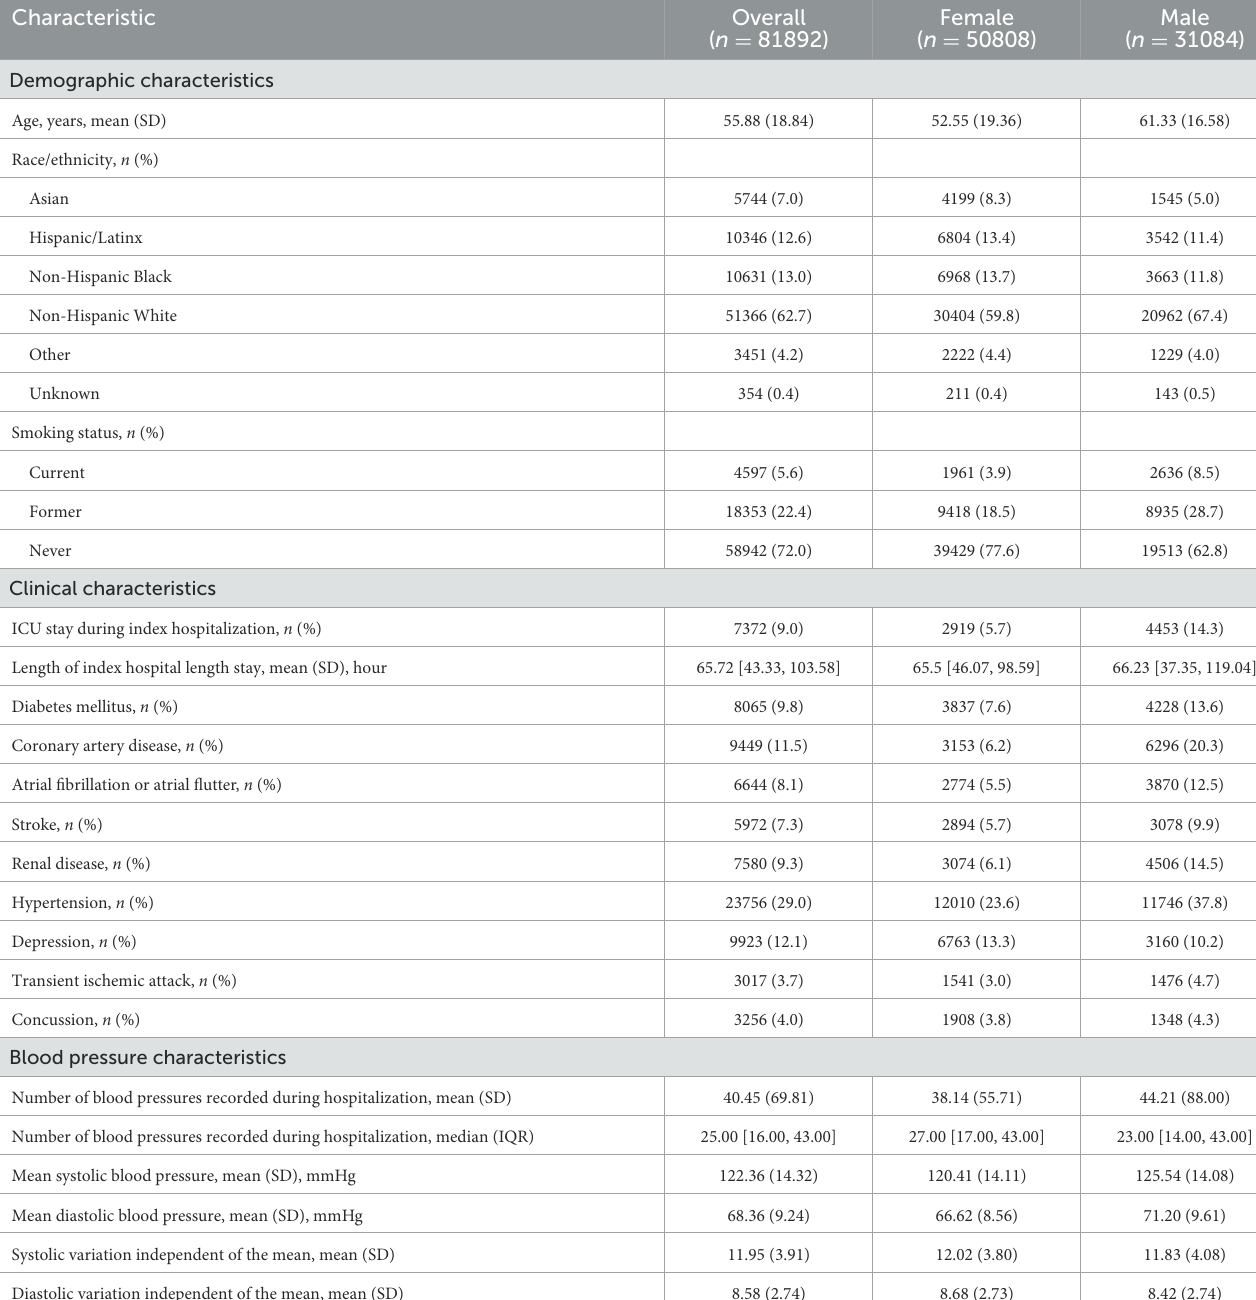
TABLE 1 Demographic and clinical characteristics of cohort, stratified by